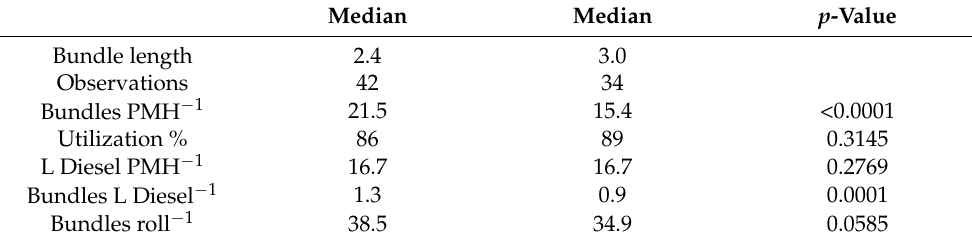
Table 3. Performance indicators for manufacturing 2.4 m vs. 3 m long bundles. Median p -Value Bundle